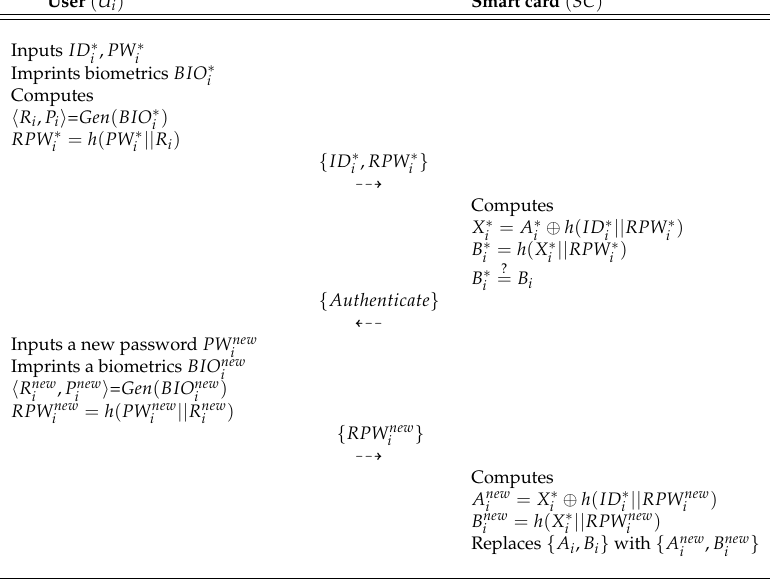
Figure 8. Password change process of the proposed